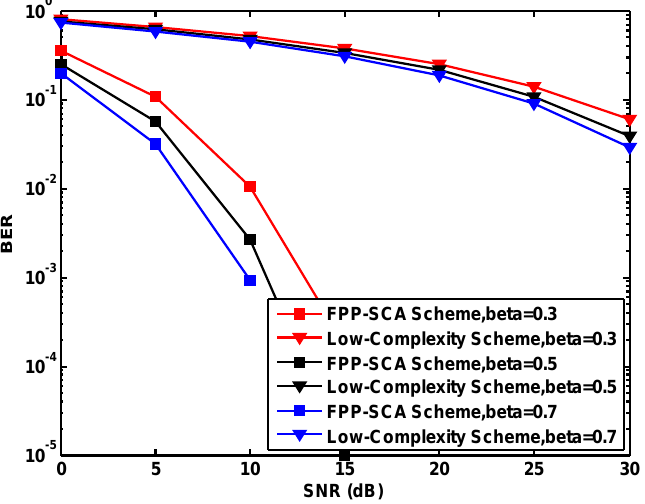
Figure 2. The bit error rate (BER) versus signal noise ratio (SNR) for the proposed schemes under different β